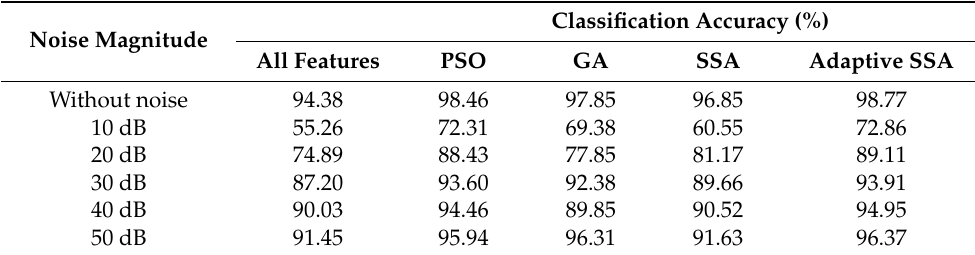
Table 7. Accuracy of PQD classification under a noisy